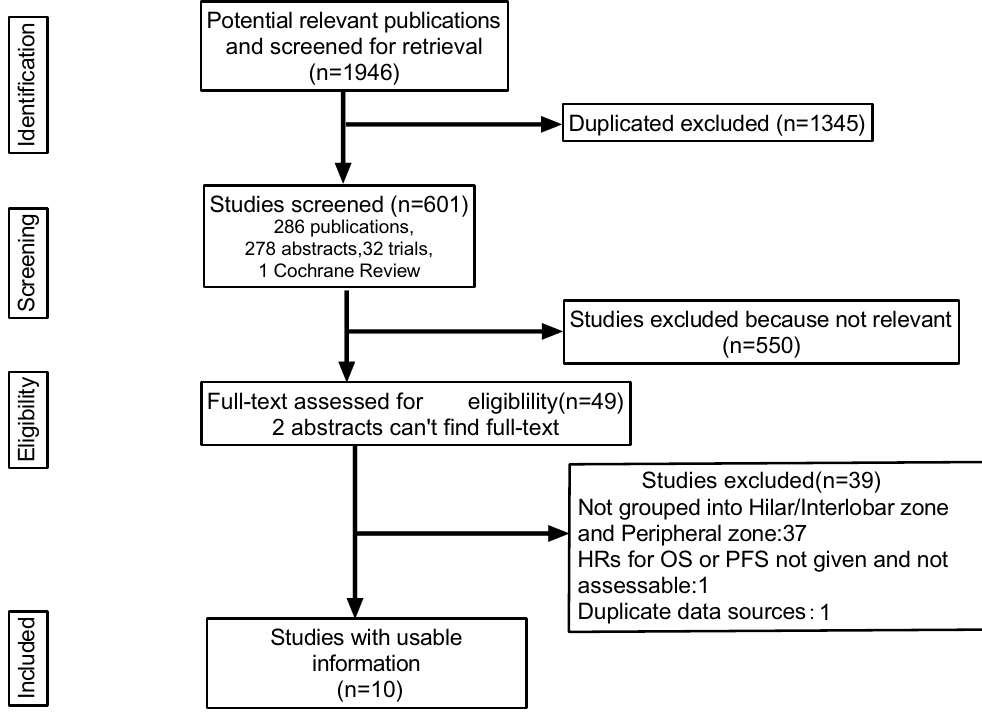
Figure 1. Literature search flow diagram.